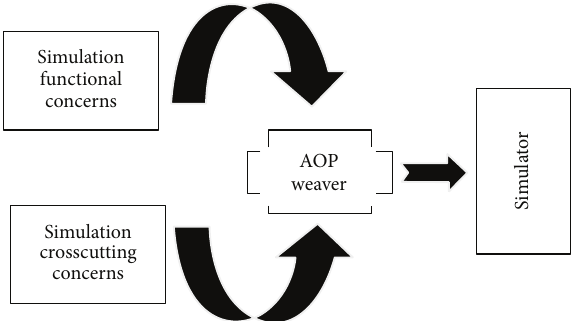
Figure 5: The process of implementing an aspect-oriented simula- tion